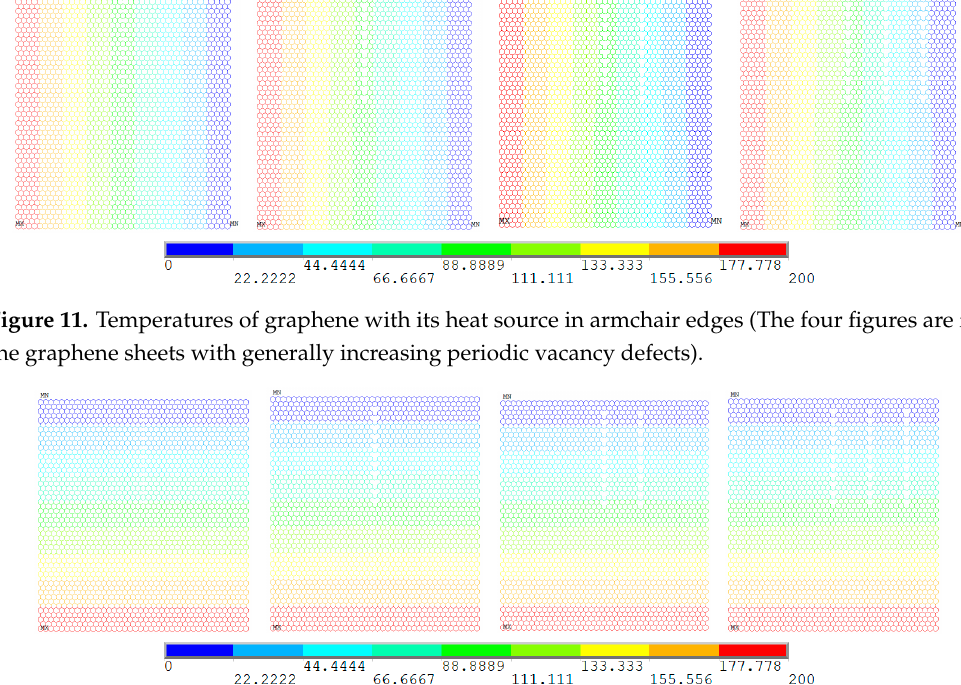
Figure 12. Temperatures of graphene with its heat source in zigzag edges (The four figures are for the graphene sheets with generally increasing periodic vacancy defects).